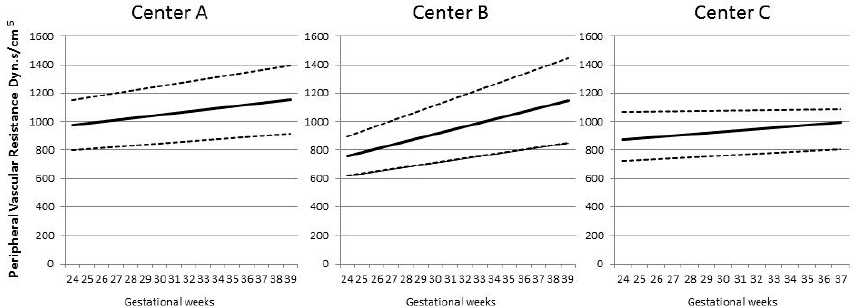
Figure 2. The figure shows the trend of maternal peripheral vascular resistance in relation to gestational week for Centre A, B and C, respectively. Differences in trends represent the different proportion of controls and cases with preeclampsia, small for gestational age/fetal growth restriction or both in the three Centres. Mean ± 1 SD (dyn.s/cm 5 ).